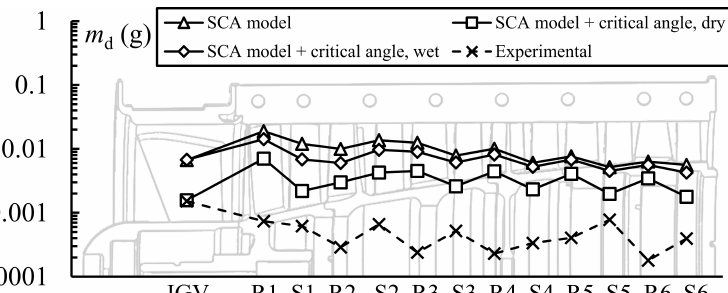
Figure 13. Comparison between the SCA model results and experimental values of the deposited mass on the compressor airfoils.